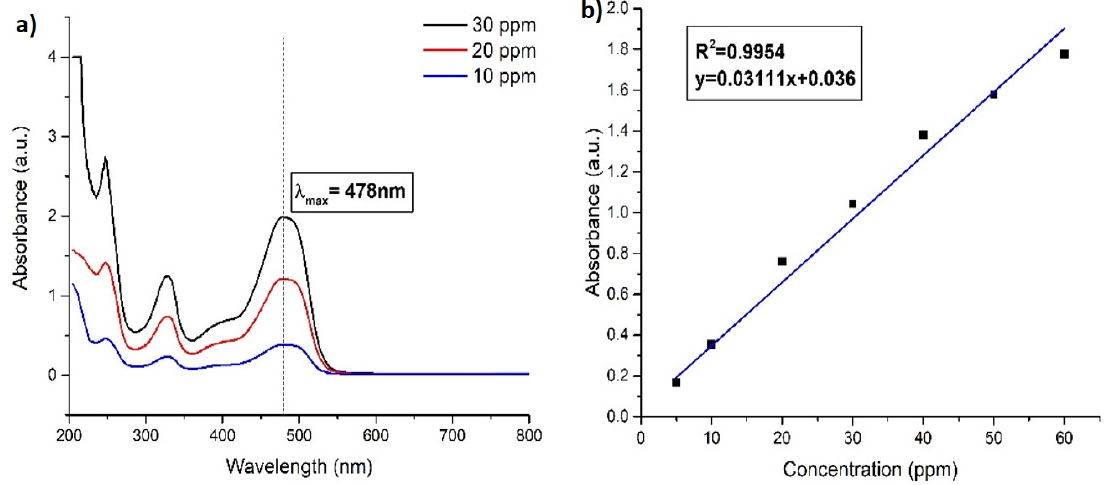
Figure 8. ( a ) UV–visible spectrum of standard Orange G solutions at different concentrations and ( b ) calibration curve of Orange G. ( b ) calibration curve of Orange